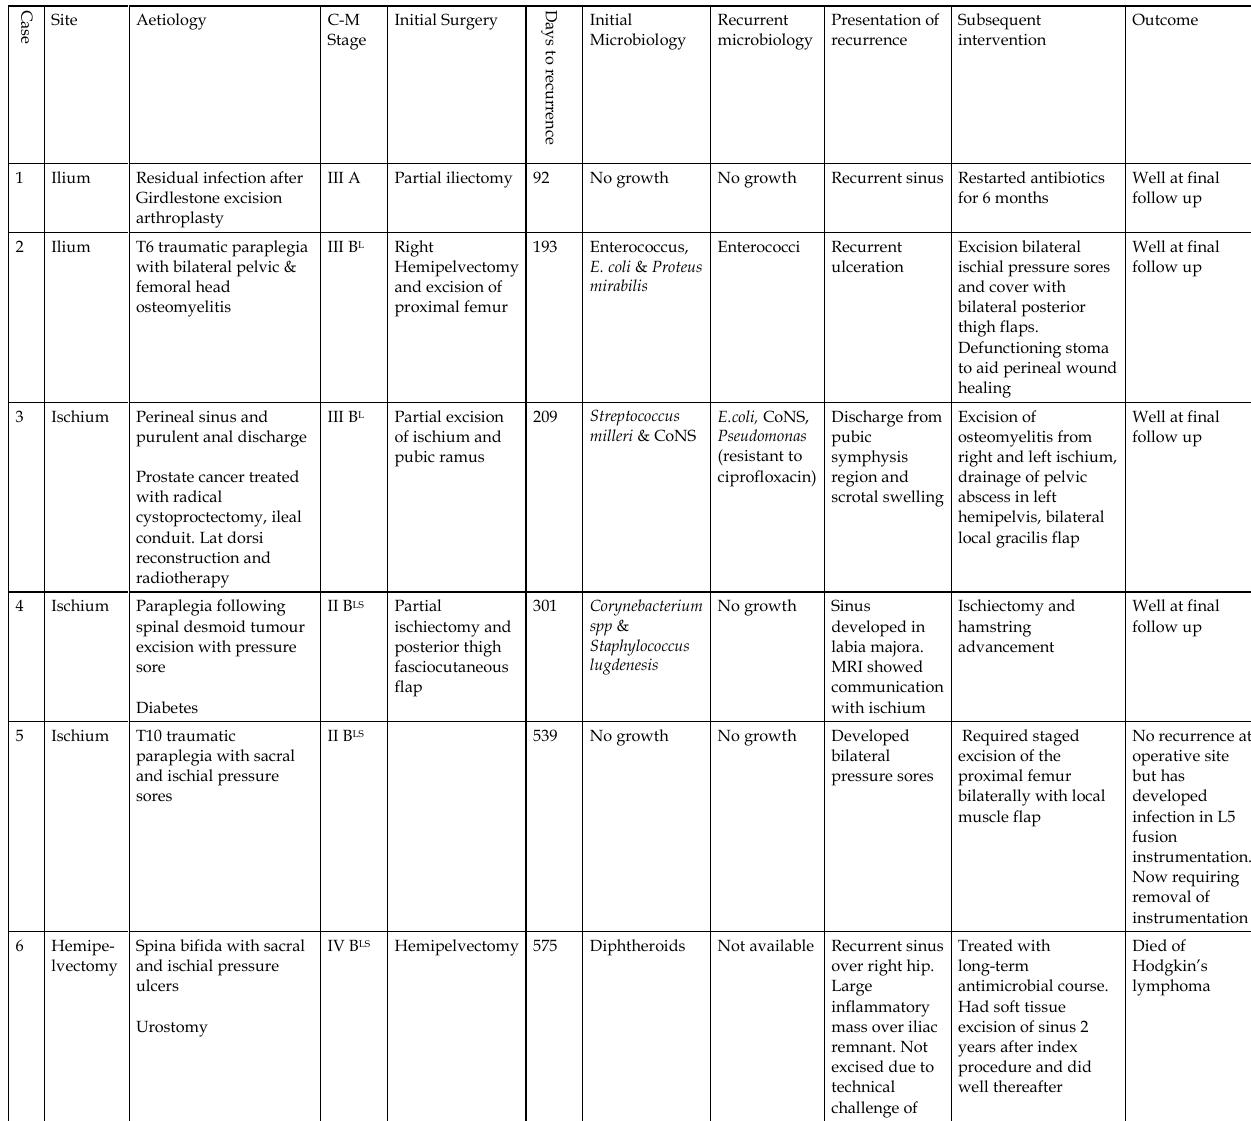
Table 5. Breakdown of the details of the infection recurrence